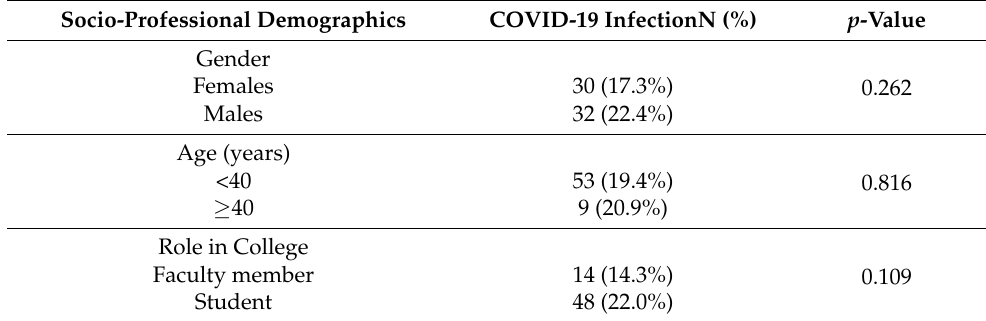
Table 1. Socio-professional characteristics of participants cross-tabulated with COVID-19 infection